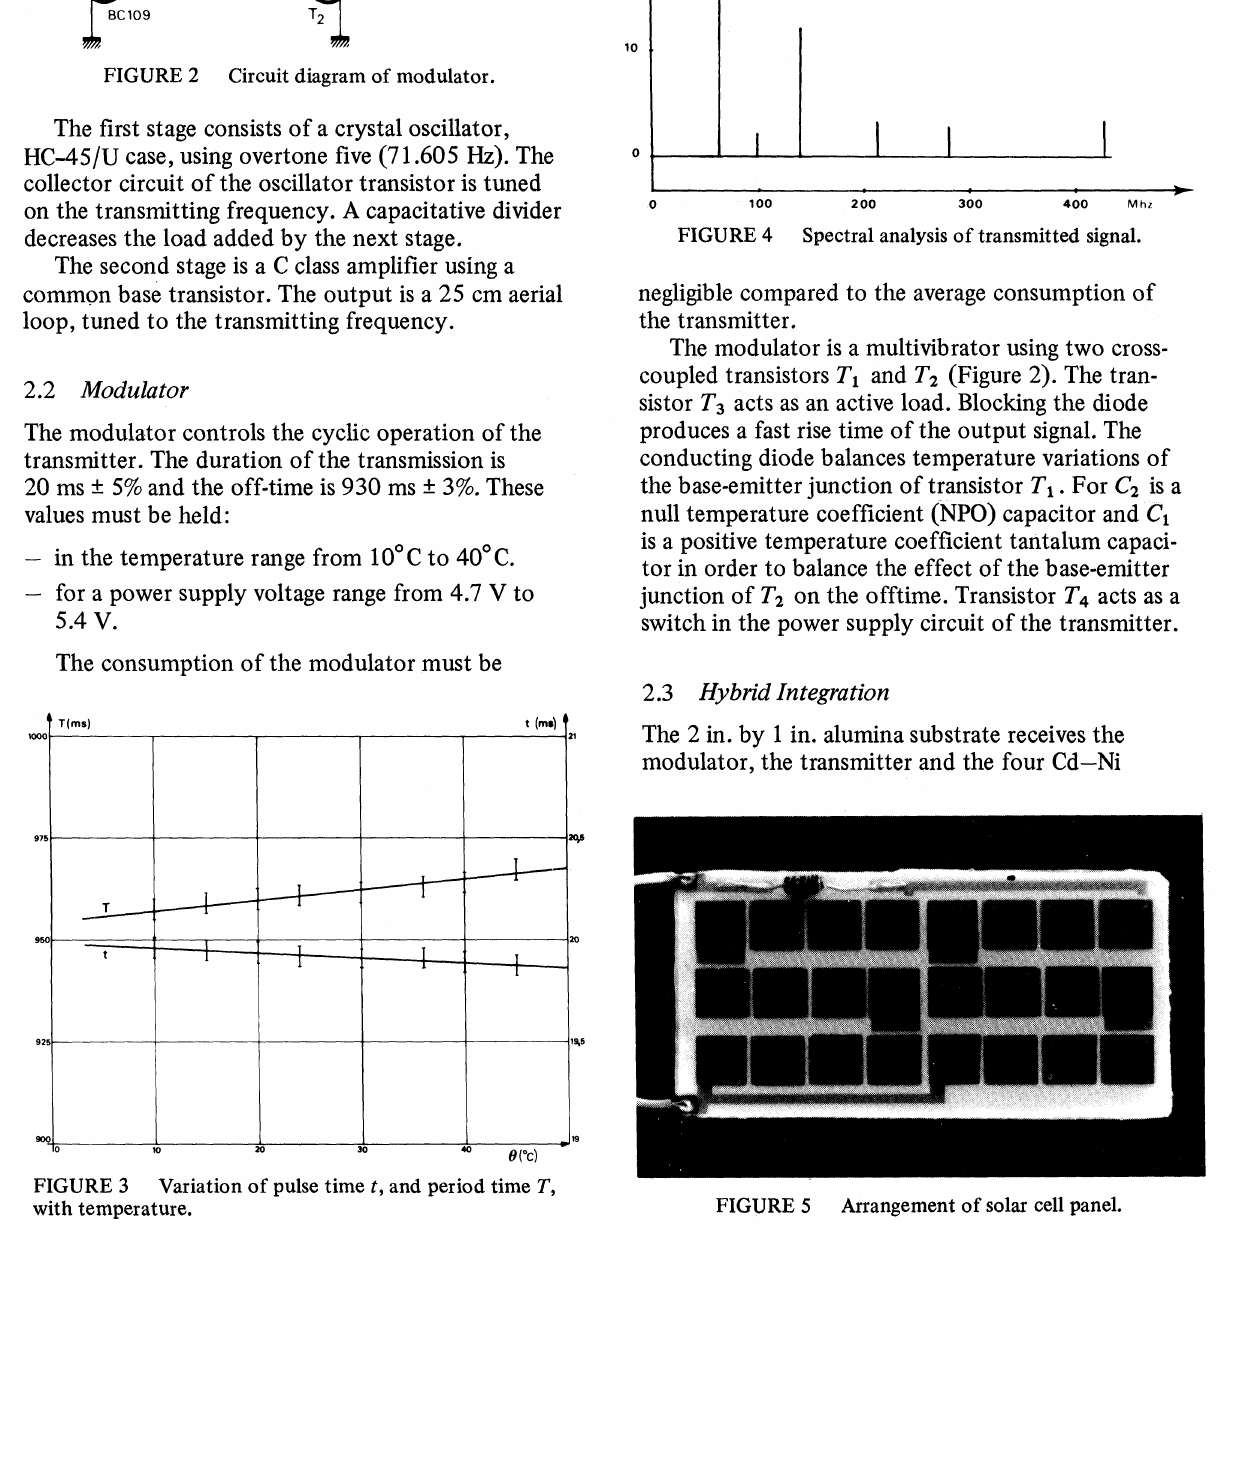
FIGURE 2 Circuit diagram of modulator.